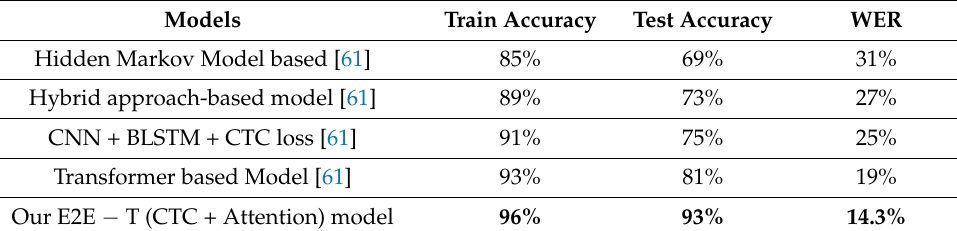
Table 7. The comparison results of the proposed E2E ASR model and other state-of-the-art-results. Models Train